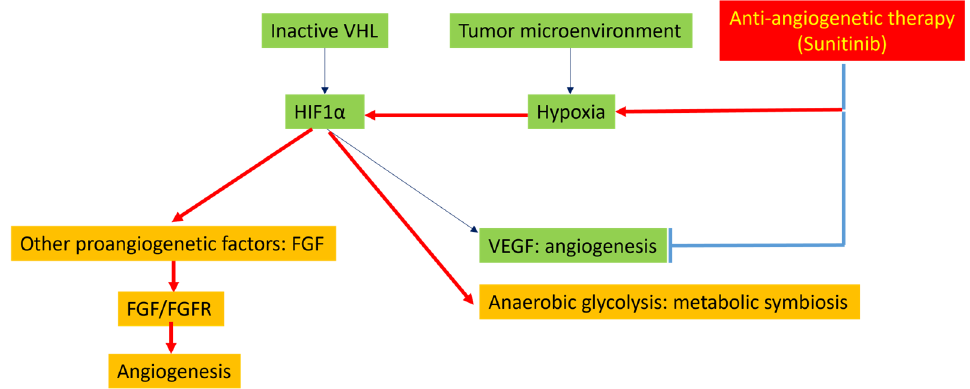
Figure 2. Potential mechanisms underlying resistance to sunitinib. Inhibition of vascular proliferation by sunitinib leads to hypoxia. Hypoxia leads to activation of HIF1 α . HIF1 α , in turn, promotes angiogenesis through activation of other proangiogenetic factors such as FGF. HIF1 α also promotes anaerobic glycolysis, featured by metabolic symbiosis.